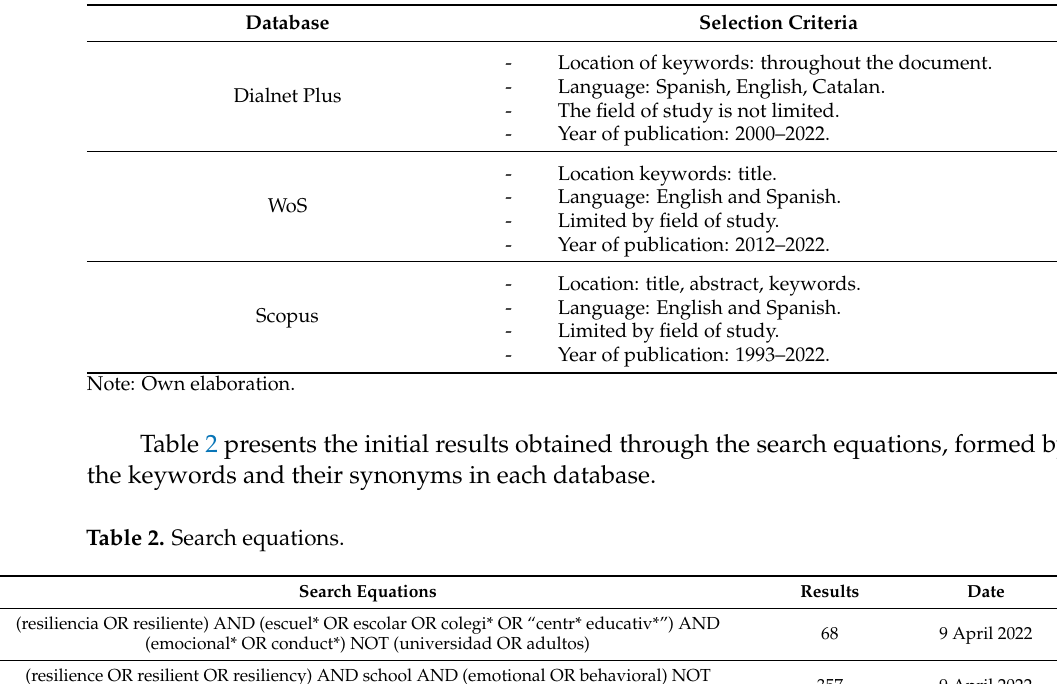
Table 1. Documentary search criteria.